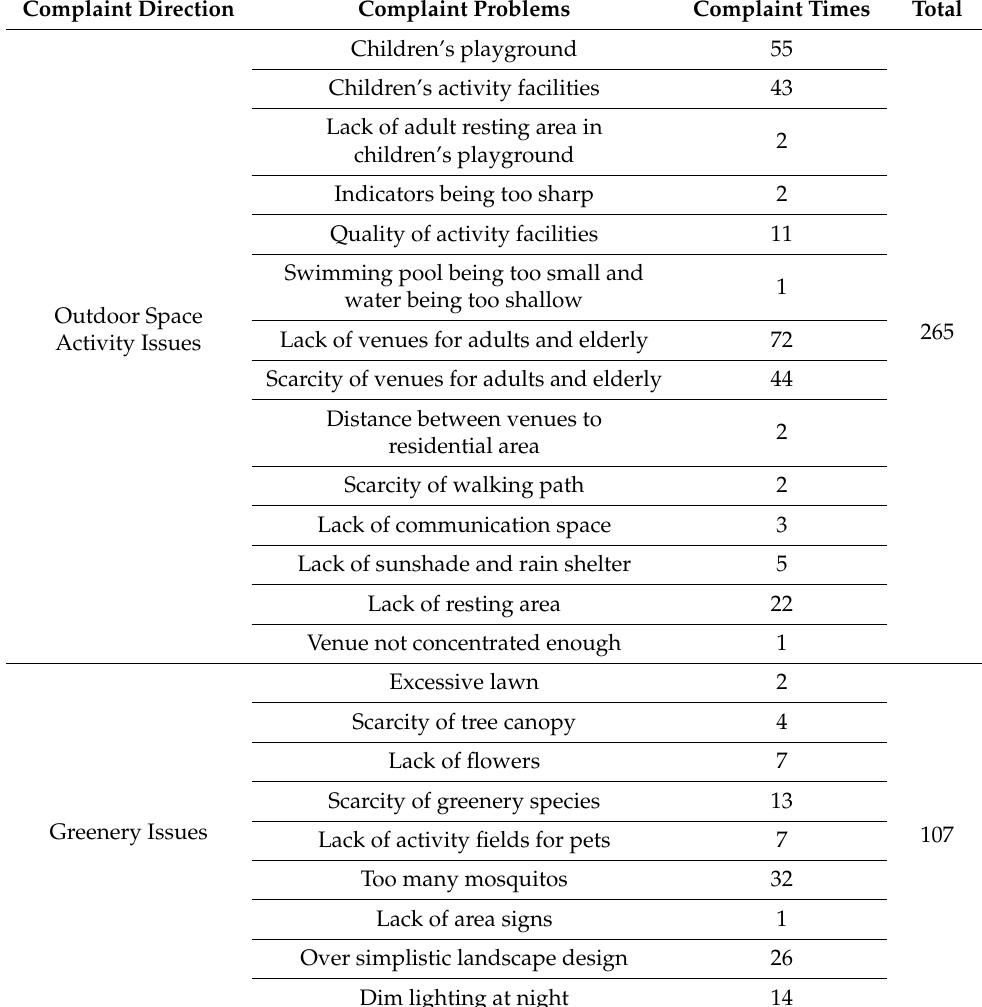
Table 1. Preliminary Research Summary on Dissatisfactory Outdoor